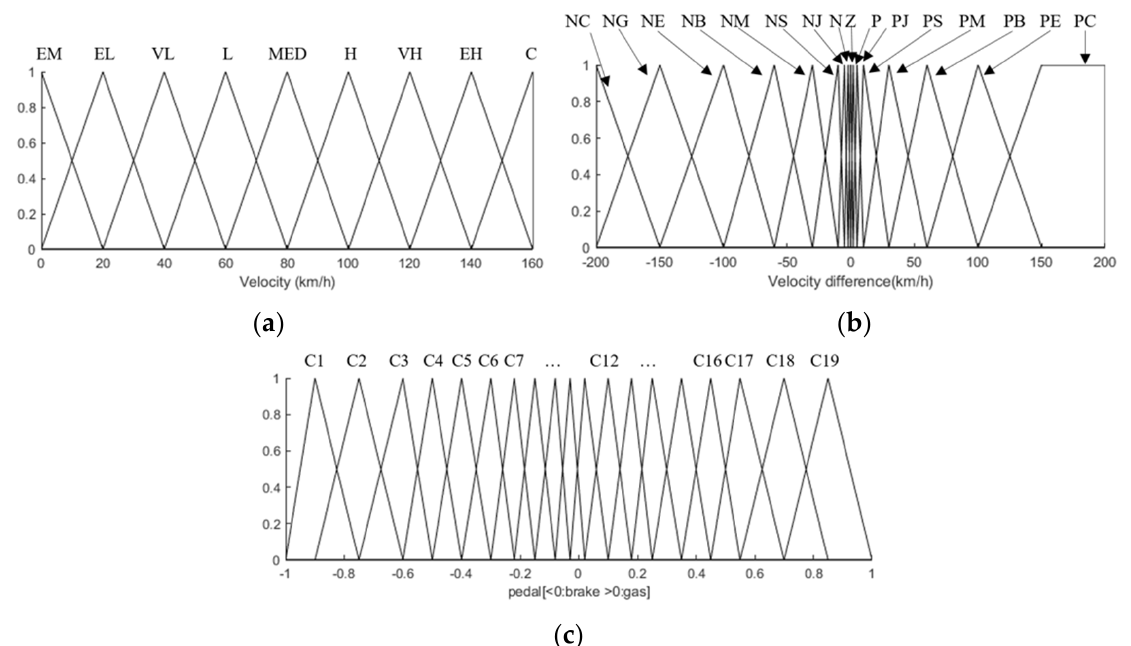
Figure 3. Inputs and outputs of the fuzzy control model. ( a ) and ( b ) are inputs, actual velocity of the vehicle and velocity difference with the desired speed. Depending on the rules in Table 1, the fuzzy control model generates outputs ( c ) that represent pedal positions.